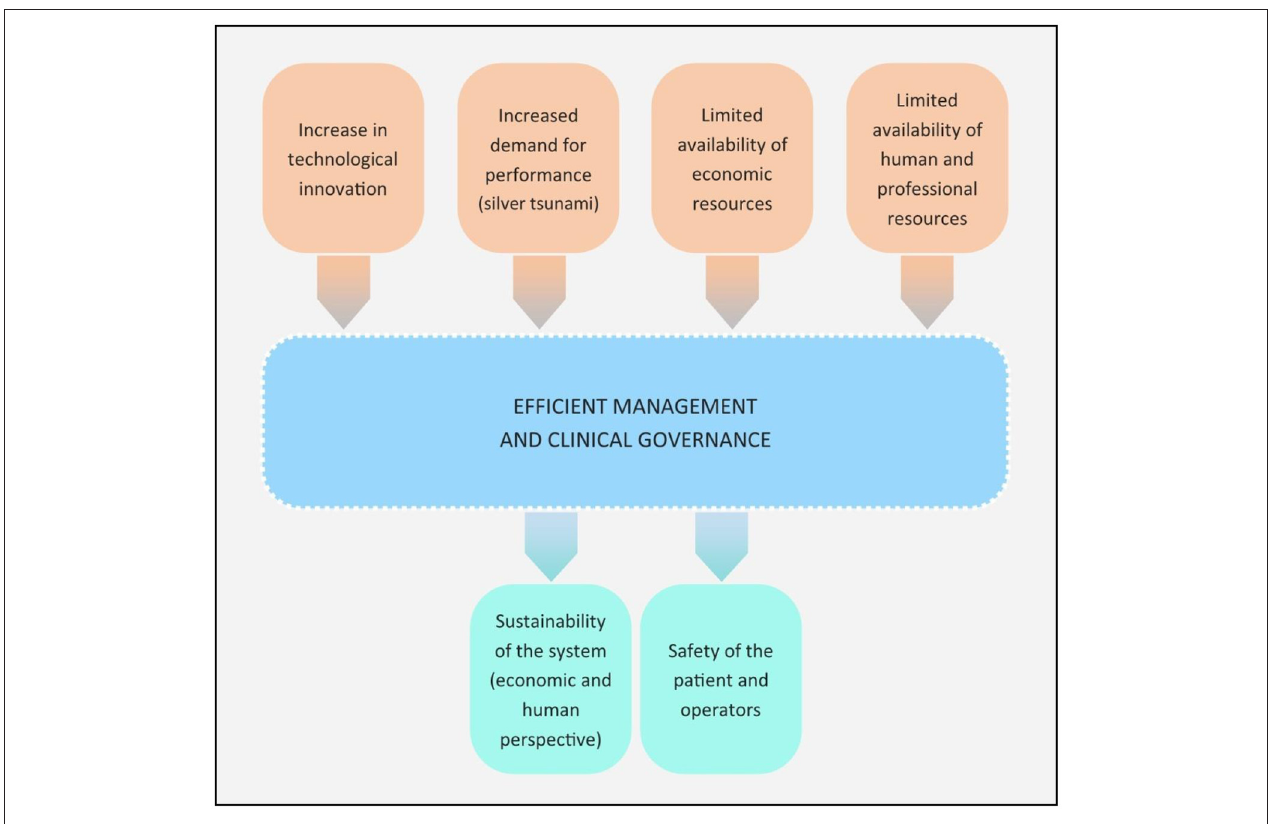
FIGURE 1 | Innovative factors within the current healthcare context.